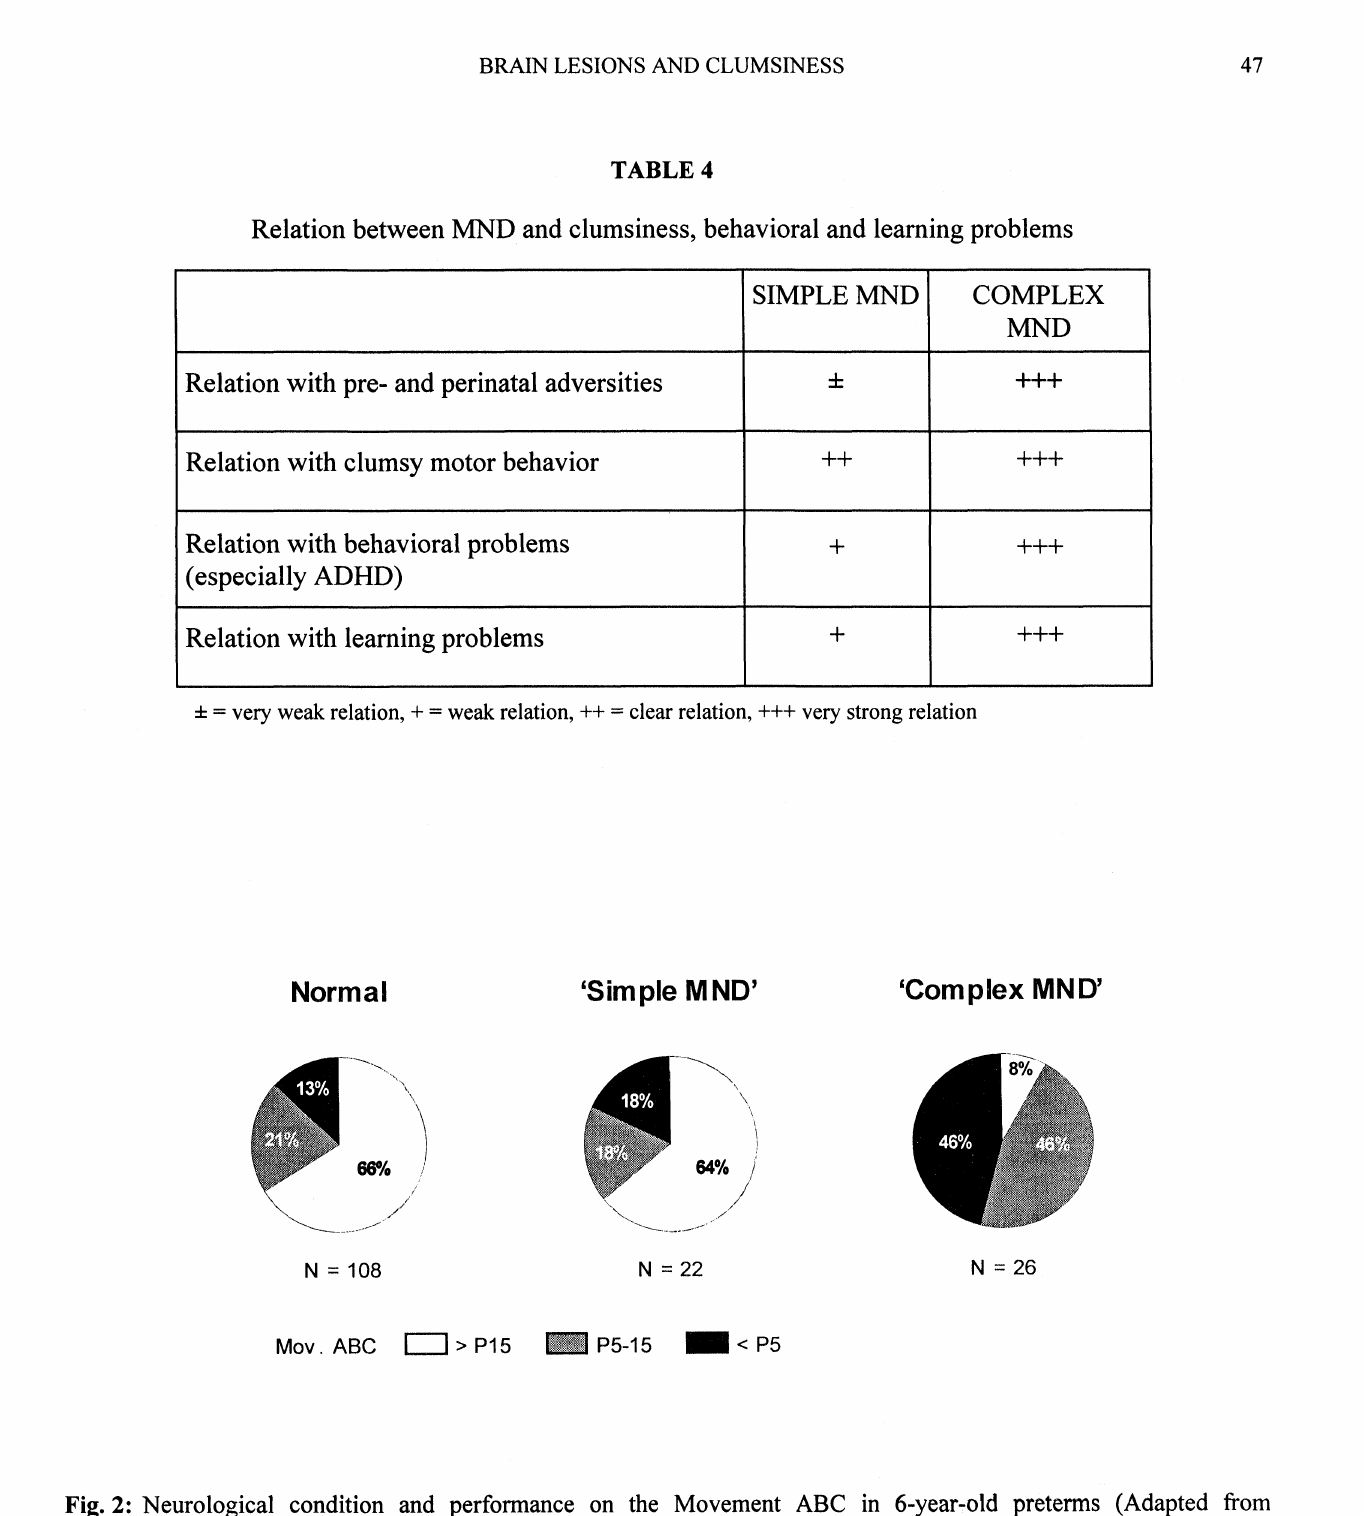
Fig. 2: Neurological condition and performance on the Movement ABC in 6-year, old preterms (Adapted from Jongmans et al. 1997.) The neurological classification is based on the neurological optimality score of the Touwen assessment. Neurologically normal represents an optimality score > 15 th percentile, ’simple MND’ denotes an optimality score between the 5 th and 15 th percentile and ’complex MND’ indicates the presence of an optimality score < 5 th